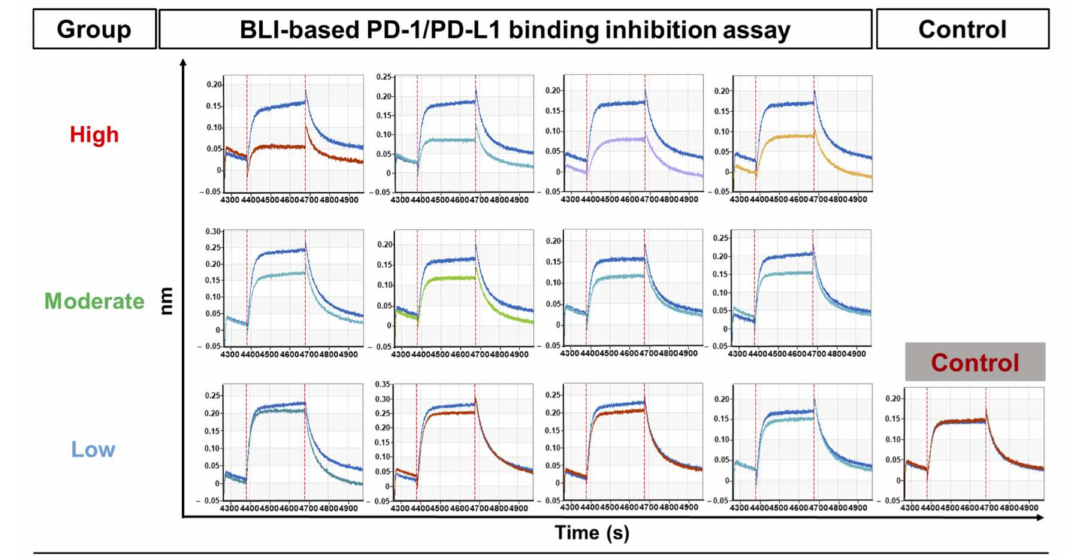
Figure 3. Screening of functional scFv antibodies using an optimized BLI-based PD-1 / PD-L1-binding inhibition assay. Inhibitory activity analysis of 72 individual periplasmic scFv antibodies. Analysis of inhibitory activity against PD-1-PD-L1 interaction was performed using BLI-based assays under optimized conditions. The relative inhibitory e ffi ciency of scFvs was calculated by normalizing the PD-1 / PD-L1-binding response in the presence of the TES bu ff er to 100%. Classification and